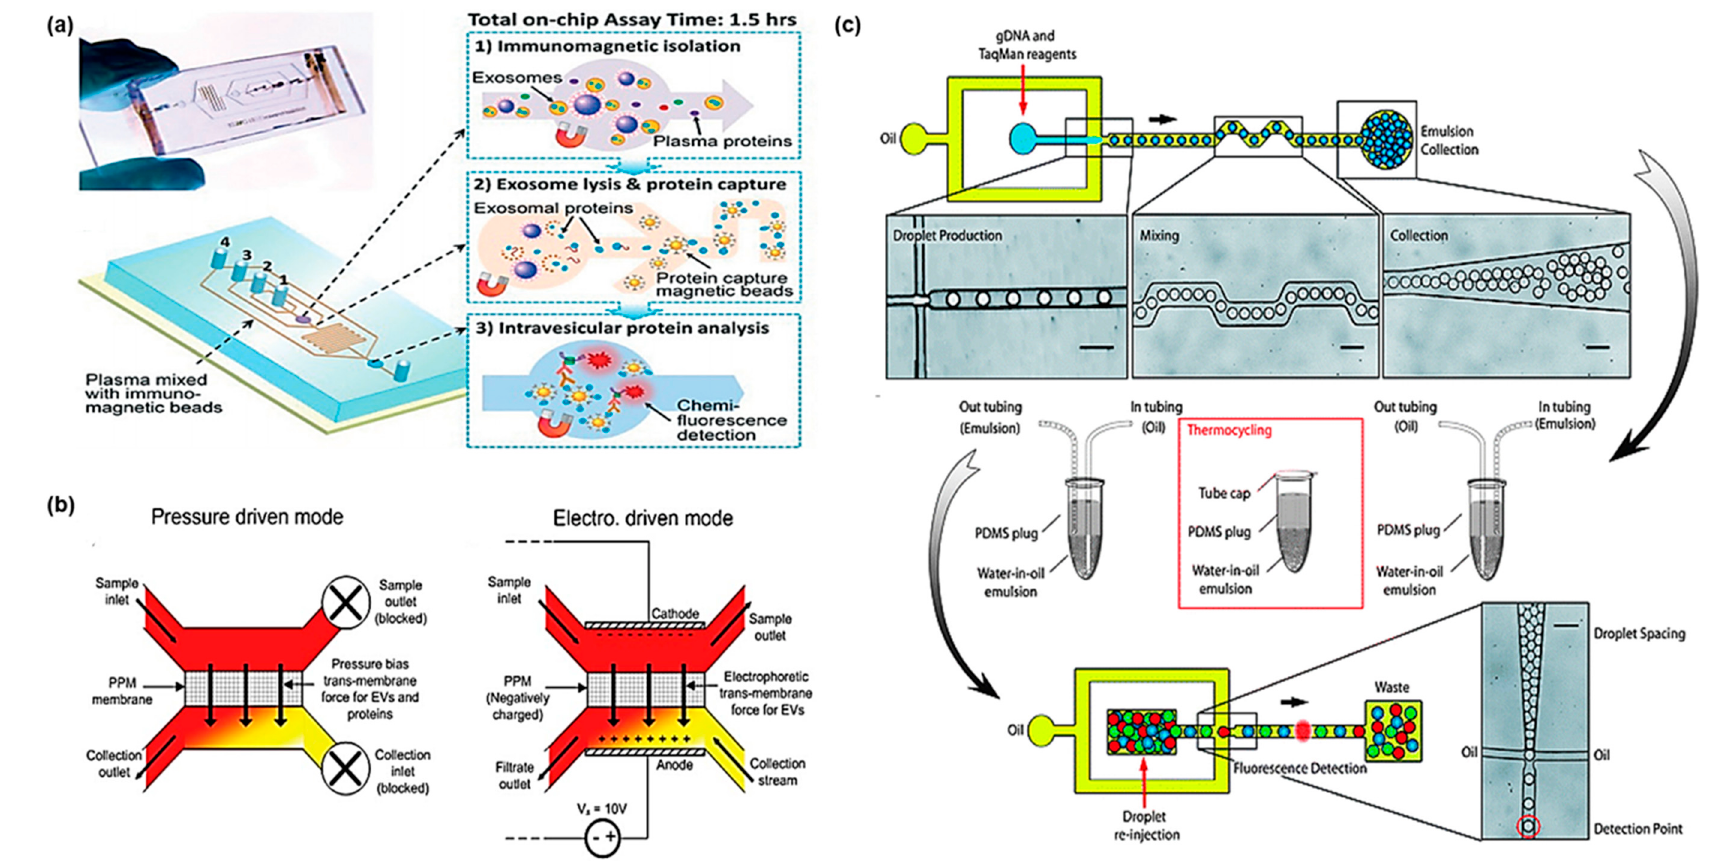
Figure 3. Microfluidic devices for exosome and cell-free DNA research. ( a ) Multistage exosome microfluidic for immunomagnetic isolation of exosome, exosome lysis, protein capture, and intravesicular protein analysis; ( b ) PPM membrane based microfluidic system for exosome filtration; ( c ) Droplet-based microfluidic device for detecting mutated DNA in a quantitative manner. Reproduced from ref. [33,37,39] with permission from 2014 Royal Society of Chemistry, 2012 Royal Society of Chemistry, and 2011 Royal Society of Chemistry.